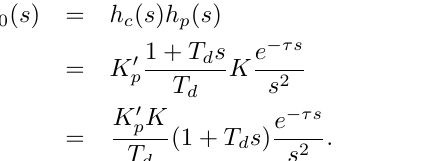
Figure 1: Feedback system. Plant model h p ( s ), distur- bance model h v ( s ) and controller h c ( s ). Dis- turbance v at the input when h v ( s ) = h p ( s ) and at the output when h v ( s ) = 1.